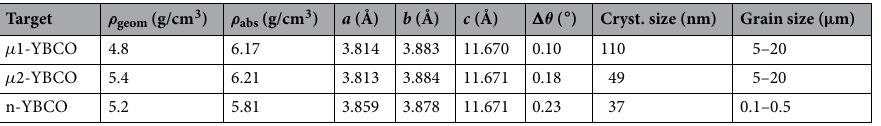
Table 1. Structural properties of the targets: the geometrical and absolute densities of the targets, lattice parameters, FWHM of the 2 θ (005) peaks ( �θ ) and the target crystallite and grain sizes.